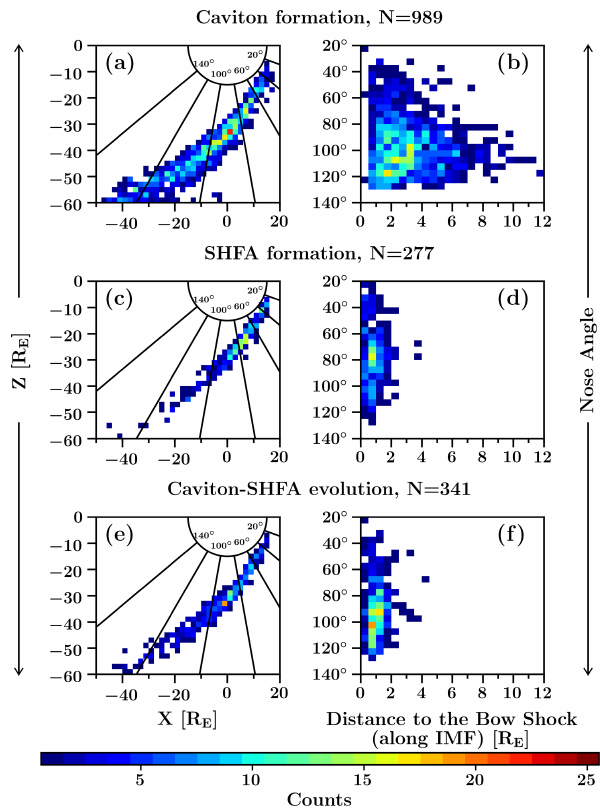
Figure 5. 2D distributions of the caviton formation locations (a, b) , SHFA formation locations (c, d) and the locations where caviton-to- SHFA evolution takes place (e, f) . Panels (a) , (c) , (e) show the lo- cations in Cartesian GSE-coordinates. Panels (b) , (d) , (f) show the locations in a distance to the bow shock vs. “nose angle”-coordinate system (see text). An overlay of the nose angle is displayed in pan- els (a) , (c) , (e) to ease the comparison between the coordinate sys-